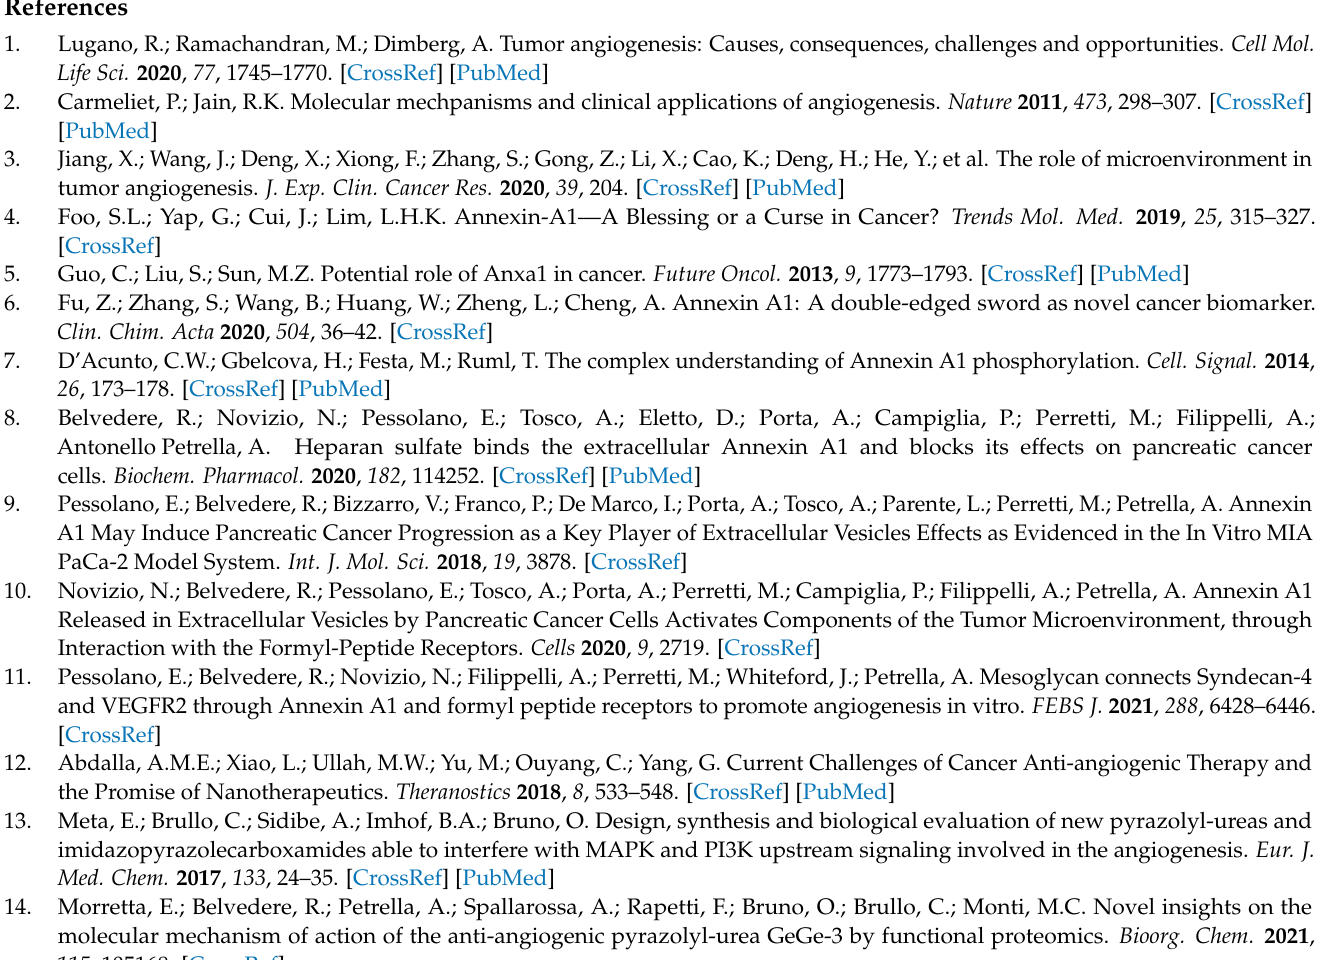
CMCF analyses; Figure S3: quantitative analyses of cell membrane ANXA1 by flow cytometry; Figure S4: densitometry analyses of western blotting of compartimentalized protein extracts; Figure S5: effects of Gege3 on ANXA1 KO EVs